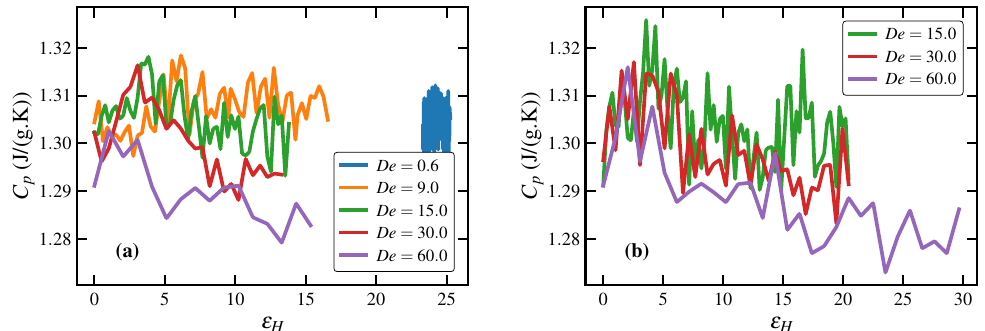
Figure 11. Specific heat capacity vs. Hencky strain of the PE melt under startup of UEF ( a ) and PEF ( b ) at various De . Note that data at De = 0.6 in panel ( a ) were taken under steady-state conditions. Ensemble-averaged measures of order, such as